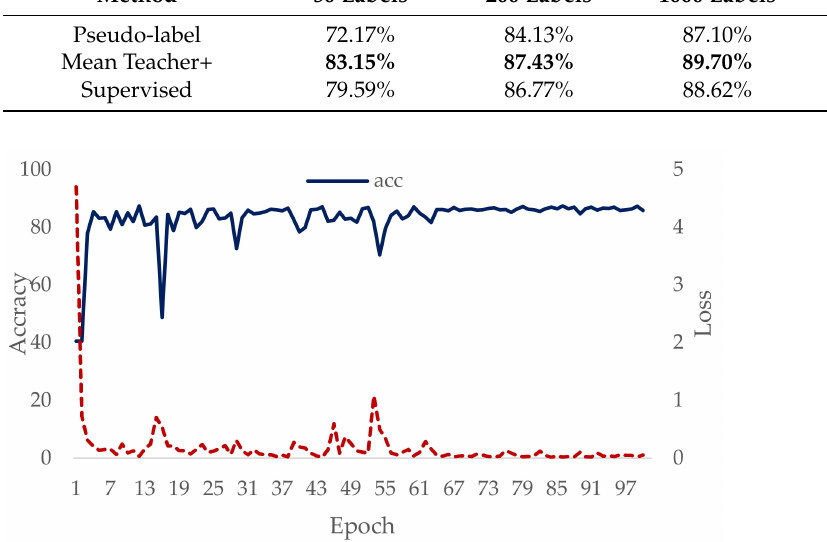
Figure 7. Loss and accuracy iteration curve.